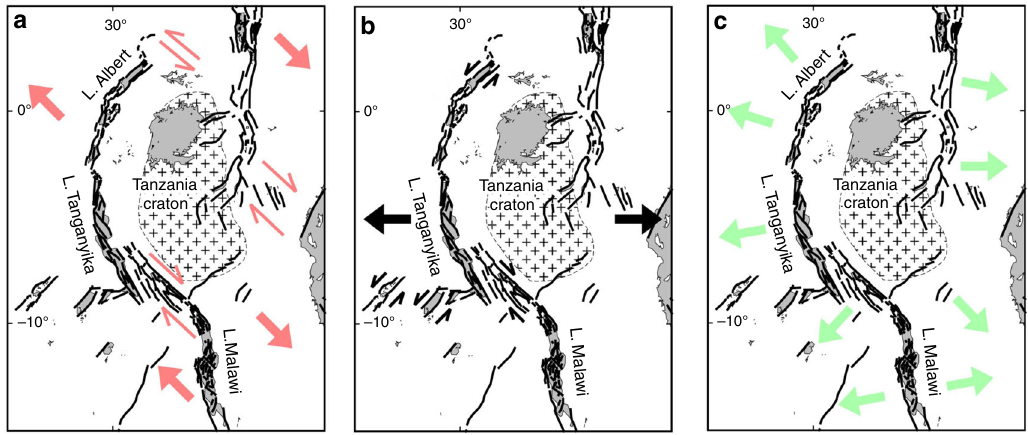
Fig. 7 Previously proposed kinematic opening models of the East African Rift System. a NW – SE regional extension with large strike – slip motion on NW- striking structures such as the Tanganyika – Rukwa – Malawi segment 25 . b Regional E – W extension leading to a minor strike – slip component on oblique segments 53 . c Regional E – W extension with predominantly normal faulting suborthogonal to the rift segments